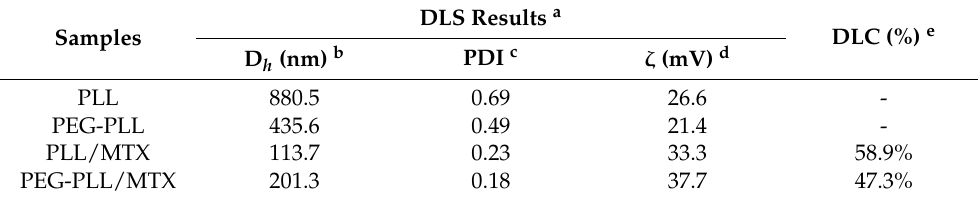
Table 1. Data of the PLL/MTX NPs and PEG-PLL/MTX NPs.